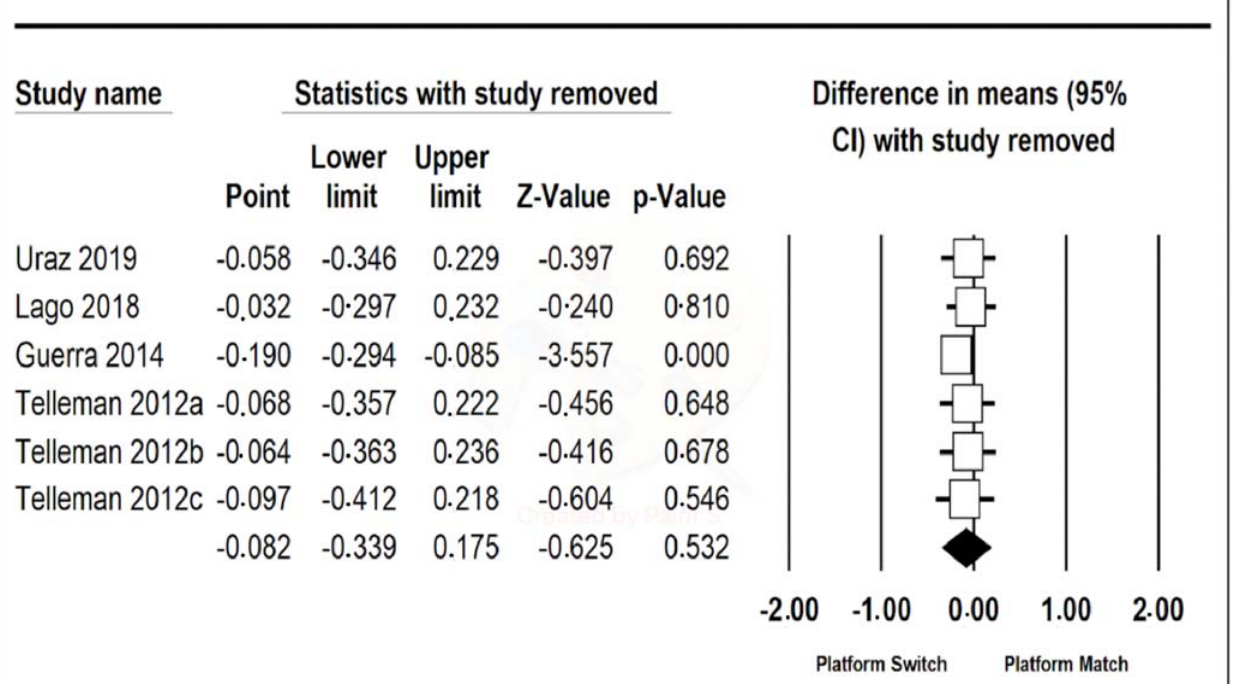
Figure 5. One Study Remove of increased probing depth.